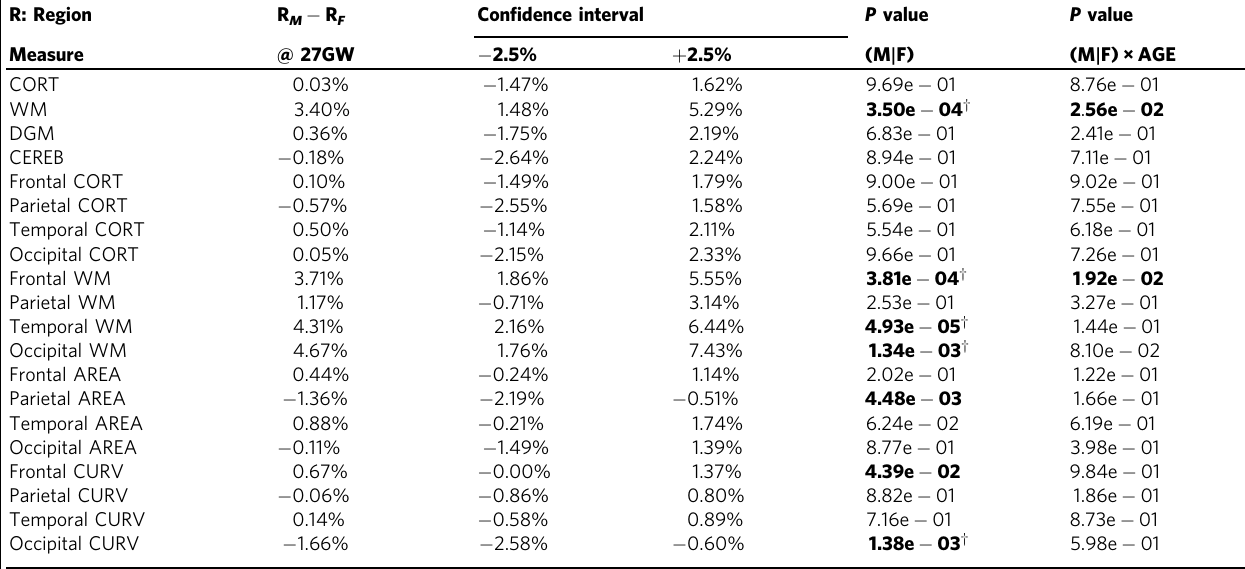
Table 2 Differences in residual relative growth trajectories.